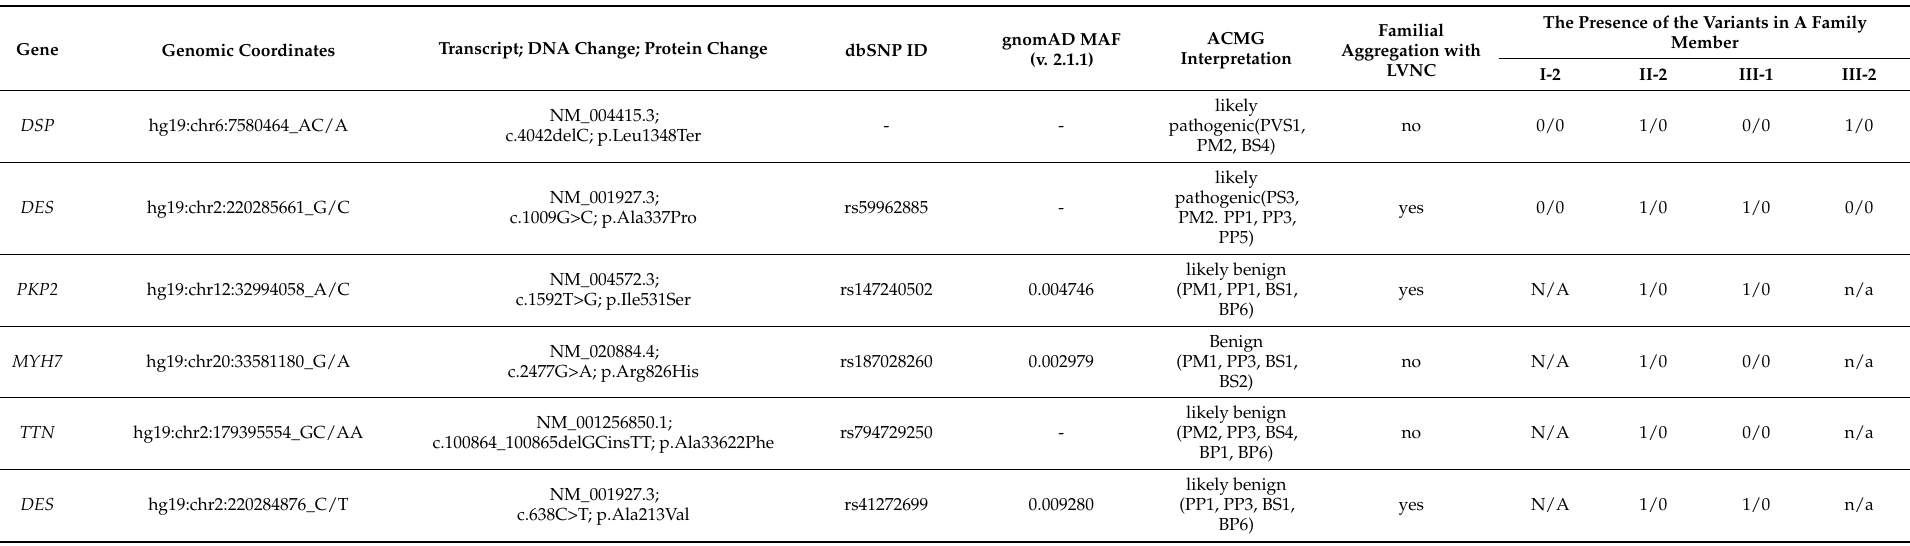
Table 1. List of the rare variants (MAF < 1%) identified in the proband and her relatives.